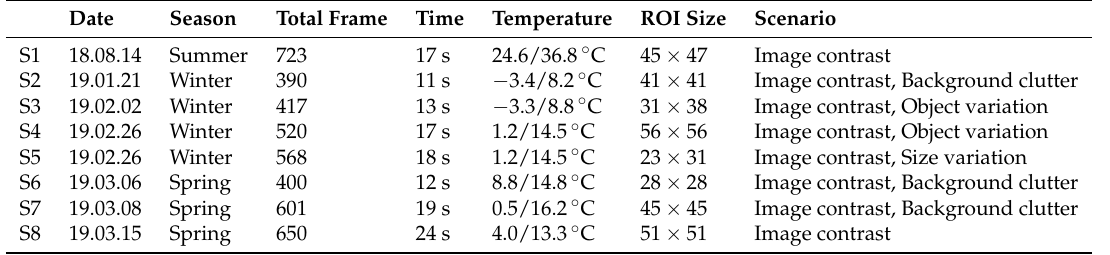
Table 2. Data acquisition and